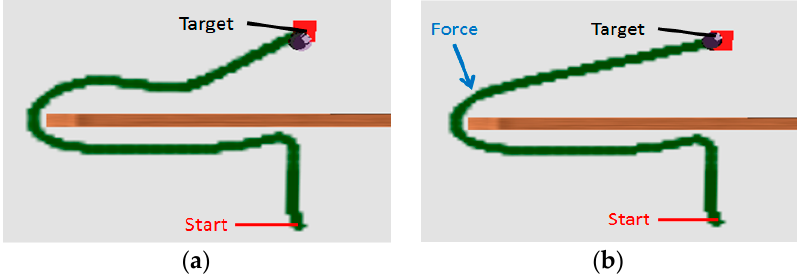
Figure 8. The trajectory of the robot using ( a ) the behavior supervisor (BS) in [14] and ( b ) the proposed modified BS.